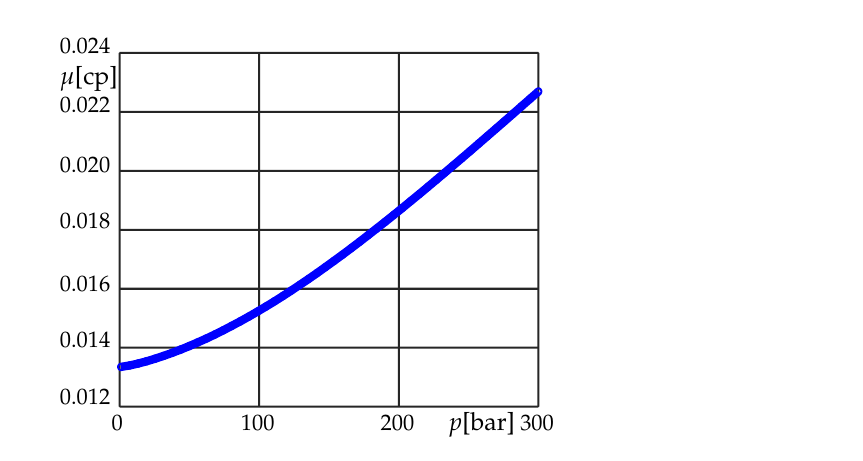
Figure 3. Methane viscosity µ (in cp, 1 cp = 1 mPa · s) estimated by the Lee–Gonzalez–Eakin empirical correlation [35] with M = 16.04 g/mol and T = 633.6 R.